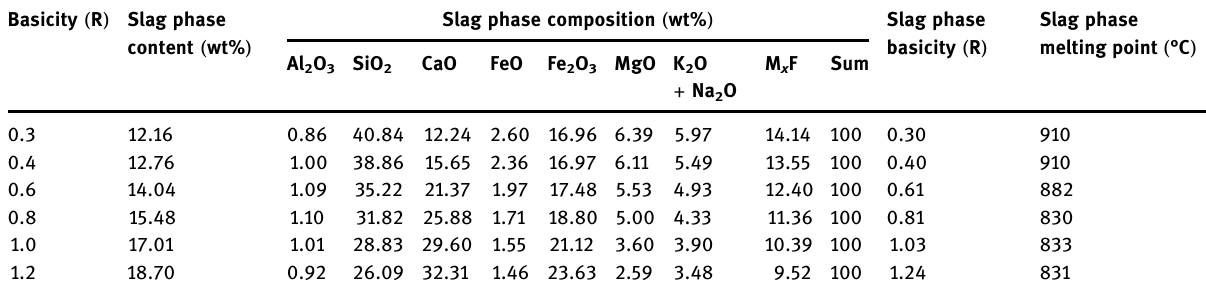
Basicity ( R ) Slag